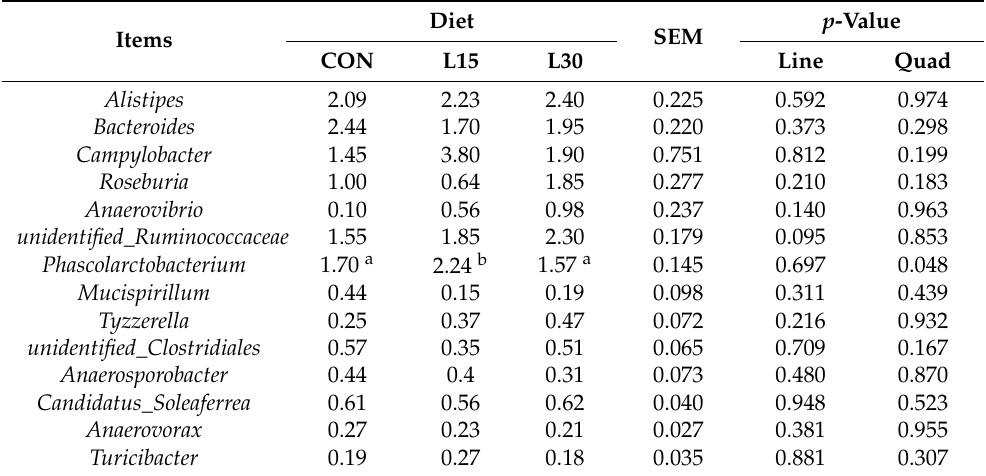
Figure 2. Effect of fermented herbal tea residue silage (FHTR) on fecal microbiota composition. The fecal microbiota composition of goats in CON, L15 and L30 group at ( A ) phylum and ( B ) genus level. Table 3. Effects of different proportion of fermented herbal tea residue on bacterium composition at general level of Chuanzhong black goats (relative abundance ≥